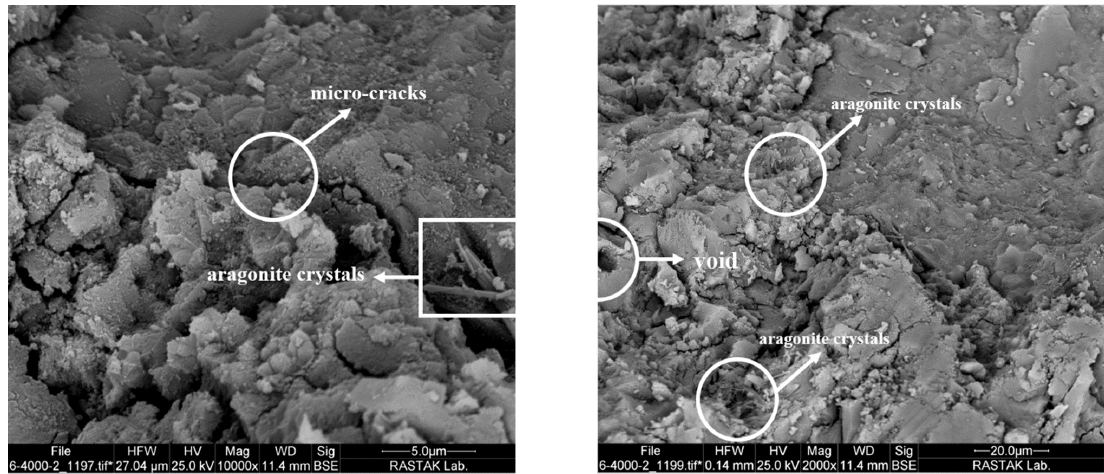
Figure 12. The SEM of concrete specimens repaired by type II bacteria.